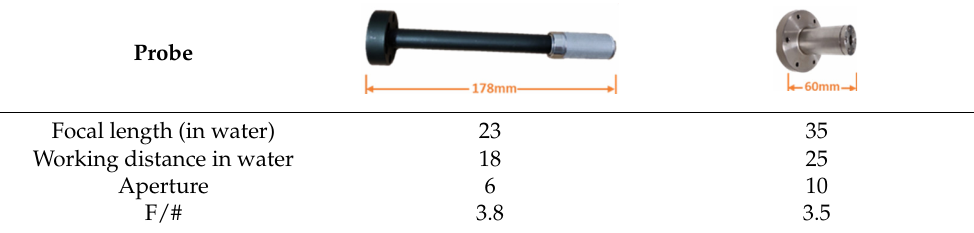
Table 4. Specifications of the changeable